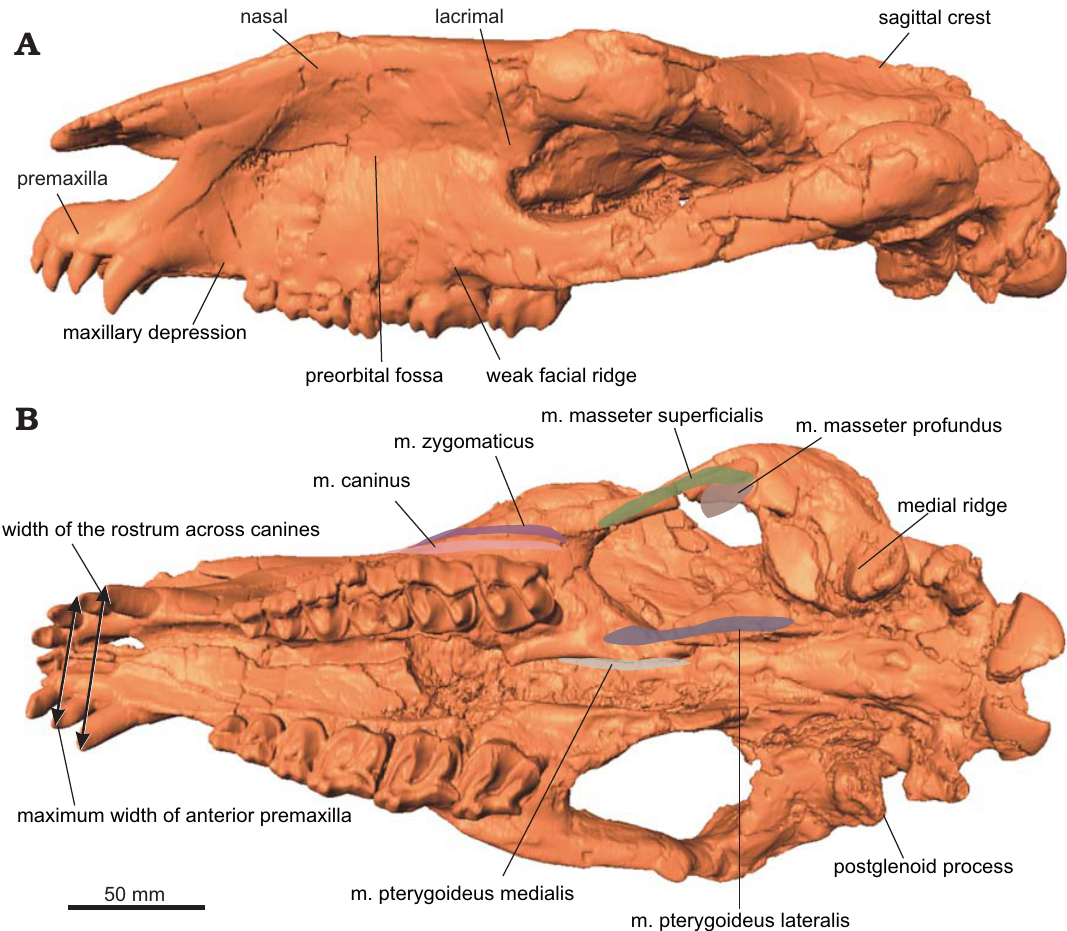
Fig. 2. Surface model of the cranium of the paraceratheriid rhinocerotoid Pappaceras meiomenus H.B. Wang, Bai, Meng, and Y.Q. Wang, 2016 (IVPP V20254) from the late Early Eocene Arshanto Formation, Erlian Basin, Nei Mongol, China, in lateral ( A ) and ventral ( B )